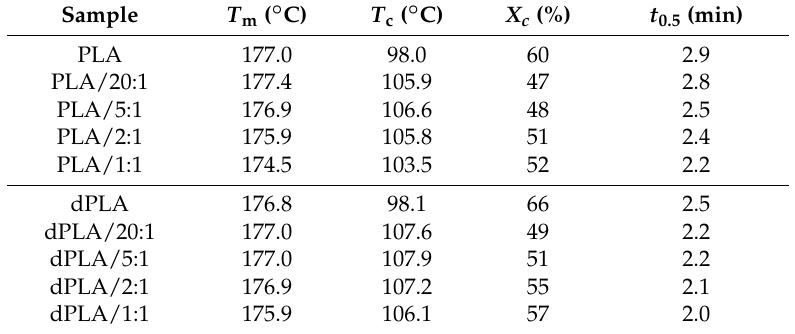
Figure 1. Differential scanning calorimetry (DSC) curves measured during the second cooling of samples: ( a ) before biodegradation and ( b ) after biodegradation. Table 2. Tabulated values of melting temperatures ( T m ), crystallization temperatures ( T c ), crystallinity degree ( X c ), and half-time of crystallization ( t 0.5 ) of samples before and after biodegradation.